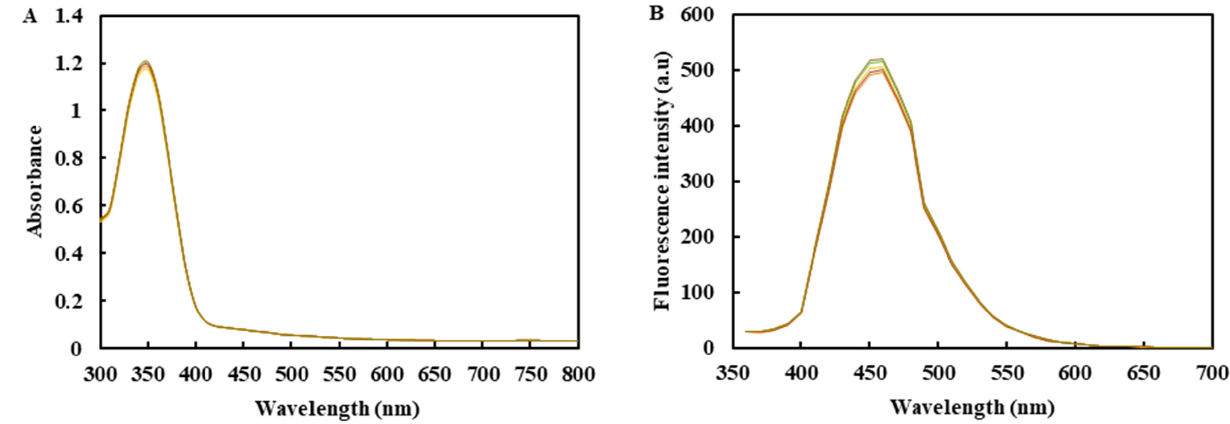
Figure 1. ( A ) Ultraviolet absorption spectrum of carbon dots (CDs) in each group. ( B ) The fluorescence emission spectrum of CDs in each group (Excitation wavelength at 360 nm).